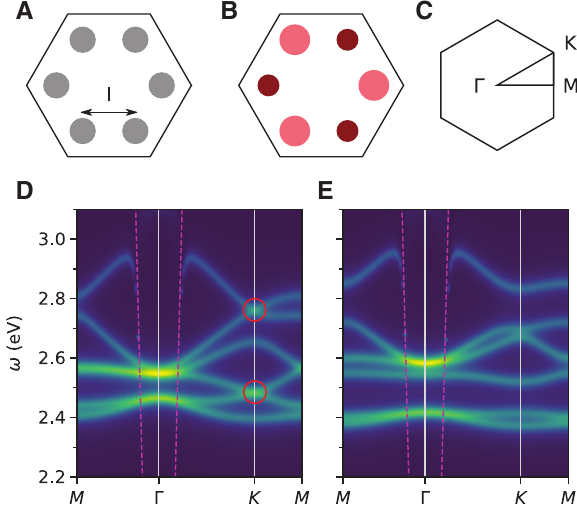
case. Figure 3: C 6 v (A) Unit cell with NP radius r = 6 nm and height h = 30 nm, nearest- neighbor spacing l = 24 nm, and lattice constant a (B) Alternating NPs are perturbed by δ r = ± 0.5 nm, with the height remaining constant. (C) BZ. (D and E) Spectral function: Highest- energy band experiences polariton-like splitting. Drude losses γ = 38 meV.